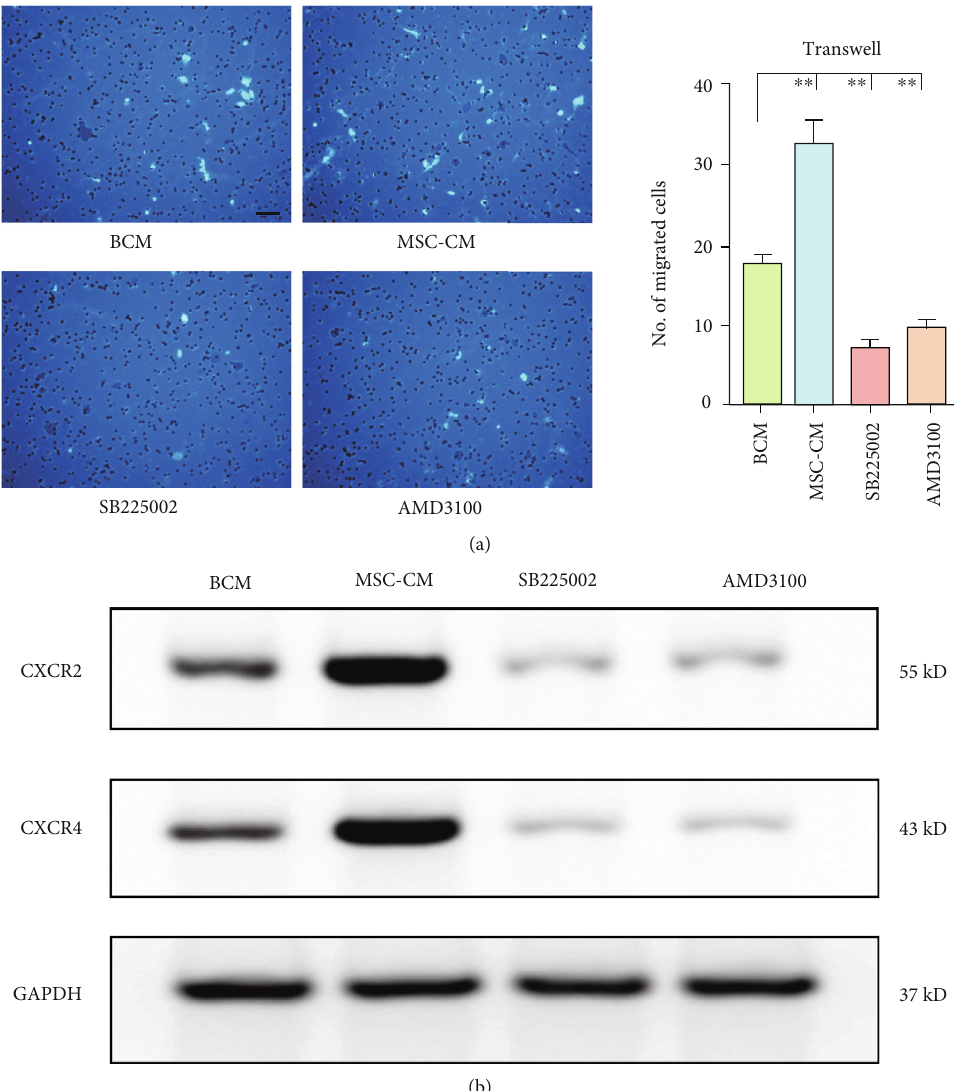
Figure 1: CXCR2 and CXCR4 levels were higher in the migrated EPCs induced by MSCs. (a) Representative images of migrated EPCs. The migration capacity of EPCs was observed using a Transwell culture system. Migrated EPCs were stained with DAPI. Scale bar, 50 μ m. The amount of migrated EPCs was quanti fi ed and presented as a bar graph ( n = 3 ; ∗∗ p < 0 : 01 ). (b) Changes of protein expressions of CXCR2 and CXCR4 after blocking CXCR2 or CXCR4. After migration, EPCs were collected and subjected to western blot. BCM: basic culture medium; MSC-CM: conditioned media of mesenchymal stem